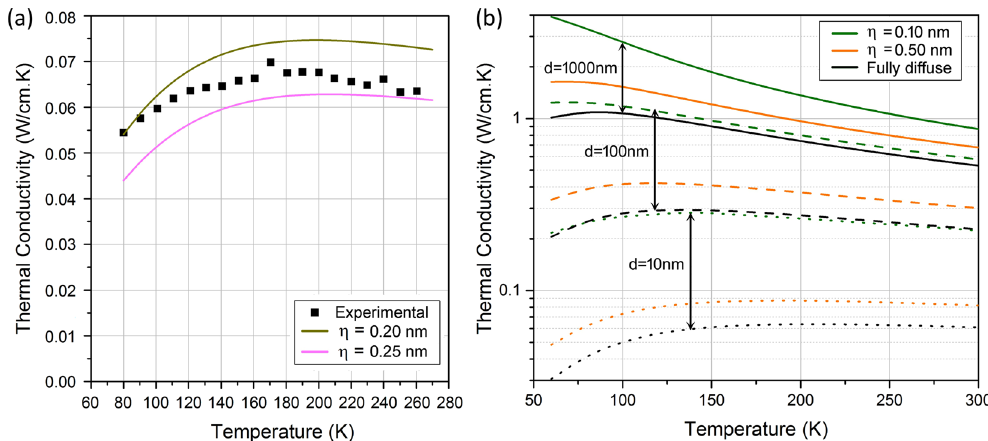
Figure 8. ( a ) Comparison between the theoretical predictions and experimental data for a 50-50 Si-Ge SL of period length 4 nm. ( b ) Temperature variation of thermal conductivity for Si-Ge SL of periods length d = 10 nm, 100 nm, and 1000 nm (dotted, dashed and solid curves respectively) at roughness values η = 0.1 nm, η = 0.5 nm and fully diffuse scattering (green, orange and black curves